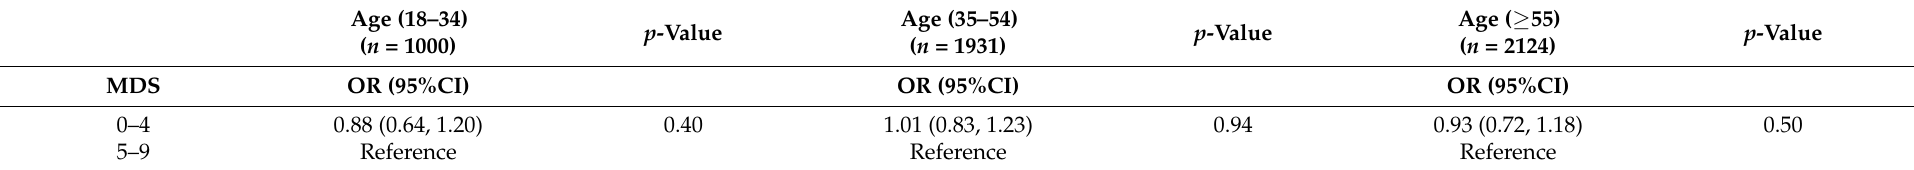
Table 3. Multivariable adjusted associations between low adherence MDS (scores 0–4 vs. 5–9) and weight related complications (EOSS 2–4 vs. 0–1) by age strata in the AHS 2011 to 2012 ( n = 5055).